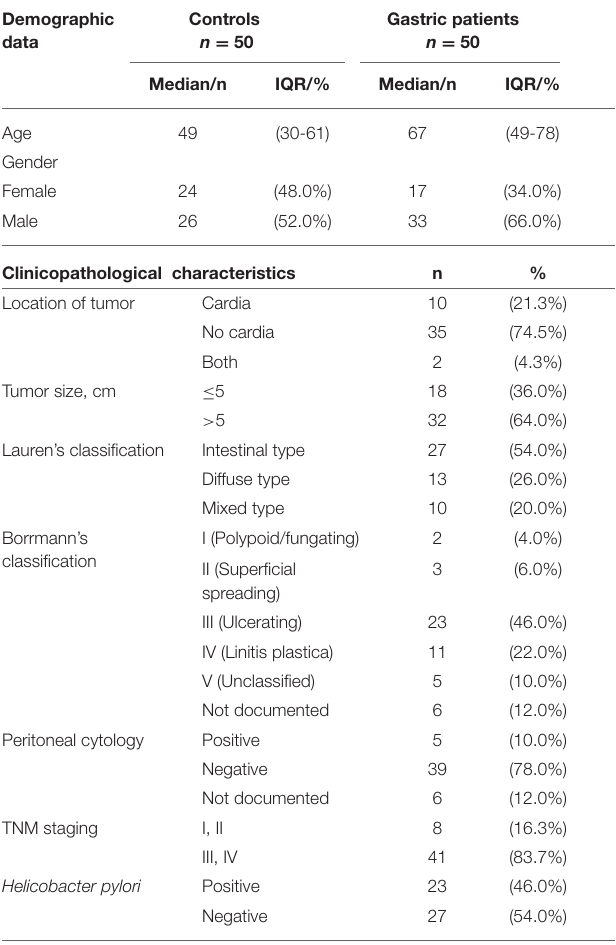
TABLE 1 | Demographic data and clinicopathological characteristics of gastric cancer patients and controls. Demographic